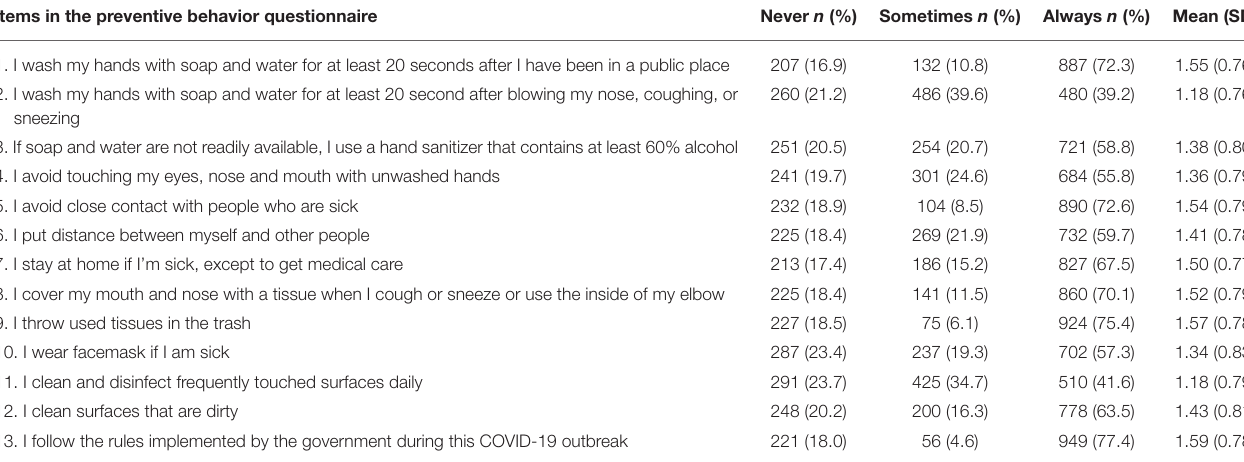
TABLE 4 | Results of the descriptive analyses on the Saudi nursing students’ preventive behaviors ( n = 1,226). Items in the preventive behavior